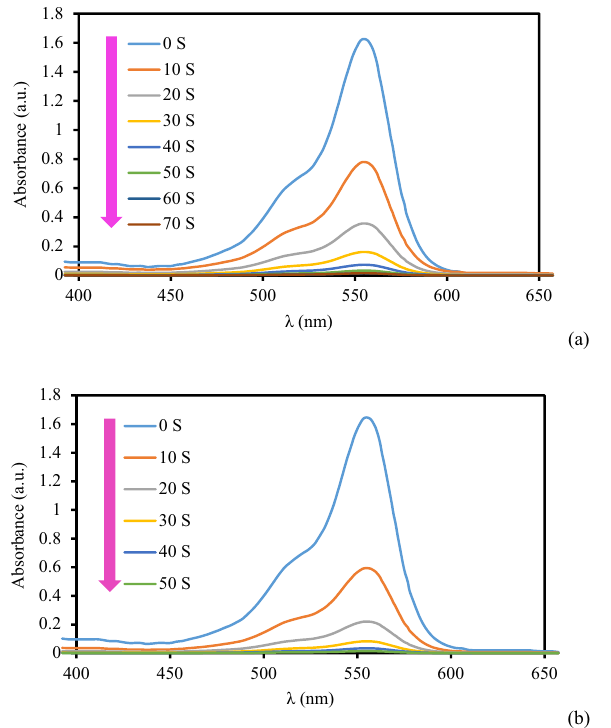
Figure 10. The absorption profile in the reduction of RhB using 3 mg ( a ) and 4 mg ( b ) of KIT-5- biguanidine-Au(0) nanocomposite.